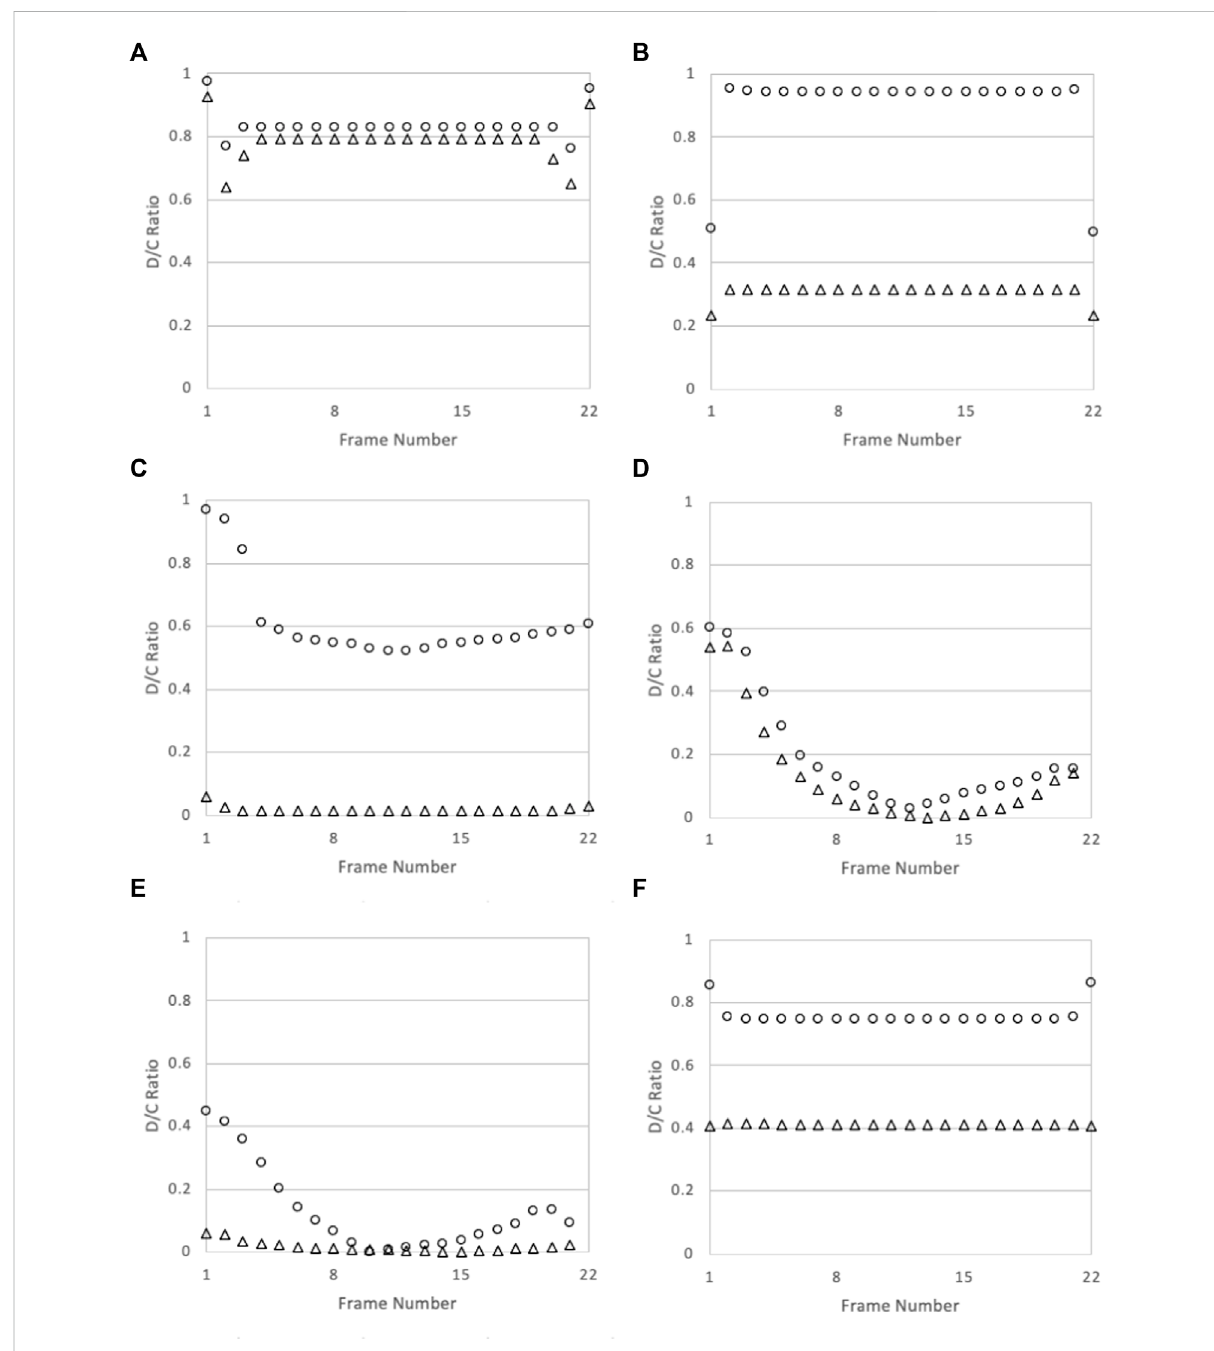
FIGURE 9 The D/C ratios of the frames throughout the roof structure: (A) Rafter; (B) Ceiling Joist; (C) Collar Tie; (D) Ridge Board; (E) Collar Tie Brace; (F) Strut. Each member has D/C ratios shown for moment ○ and shear △ . Frame numbers 1 and 22 indicate the gable end frames.